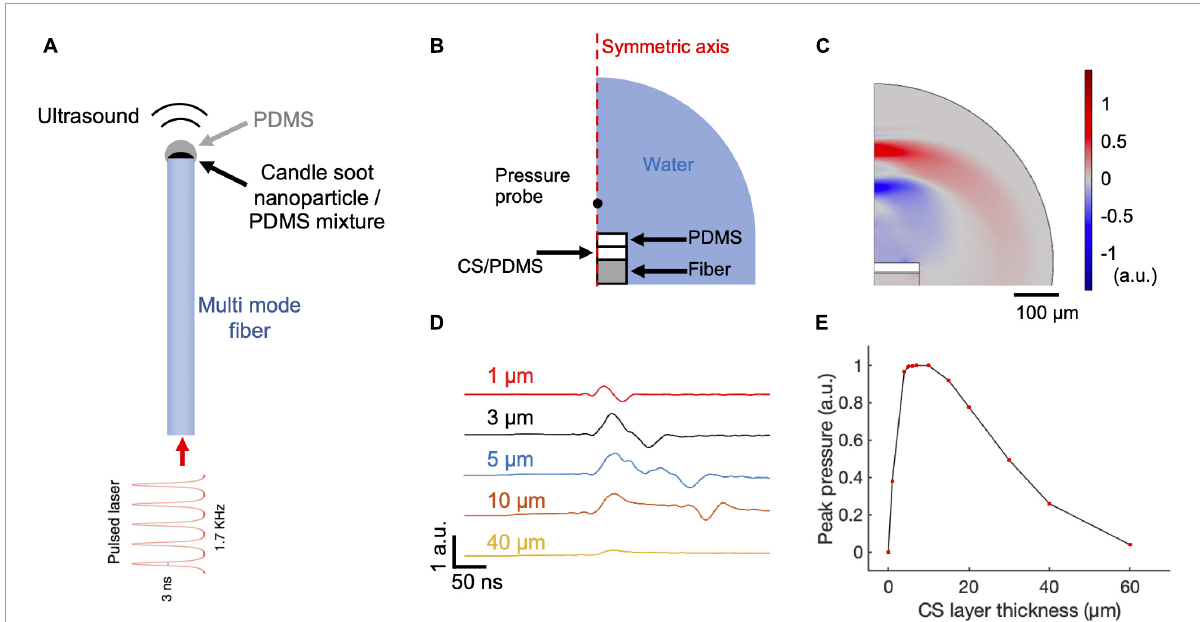
FIGURE1 COMSOL simulation of CSFOE performance. (A) Schematic of CSFOE. (B) Illustration of the CSFOE model used in simulation. Not to scale. (C) Representative ultrasound waveform, simulated at t = 400 ns under an input of a 3 ns pulsed laser. (D) Acoustic waveforms simulated at different thicknesses of the CS layer. (E) Peak-to-peak acoustic pressure plotted as a function of candle soot layer